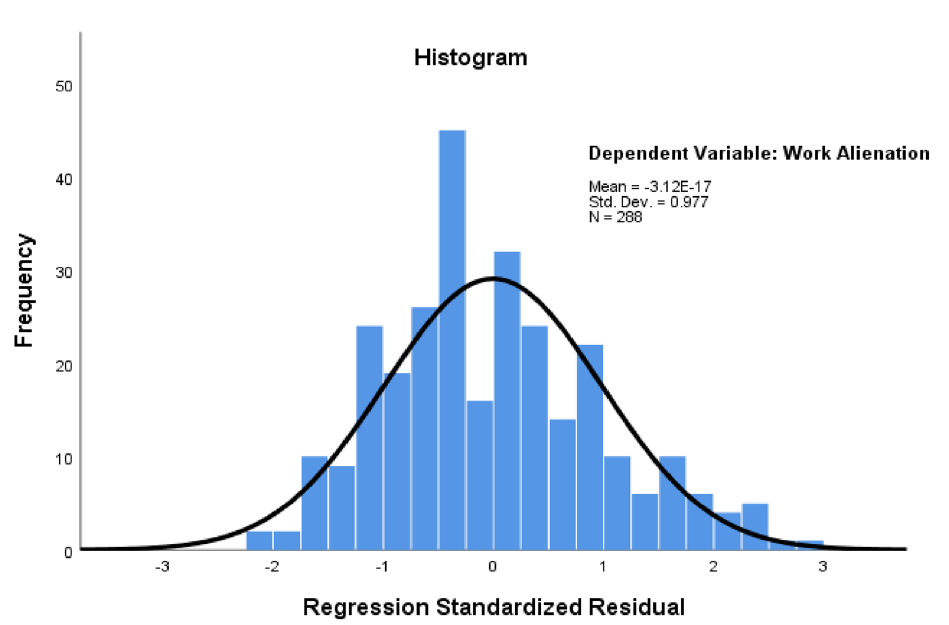
Figure 1. Regression standardized residual